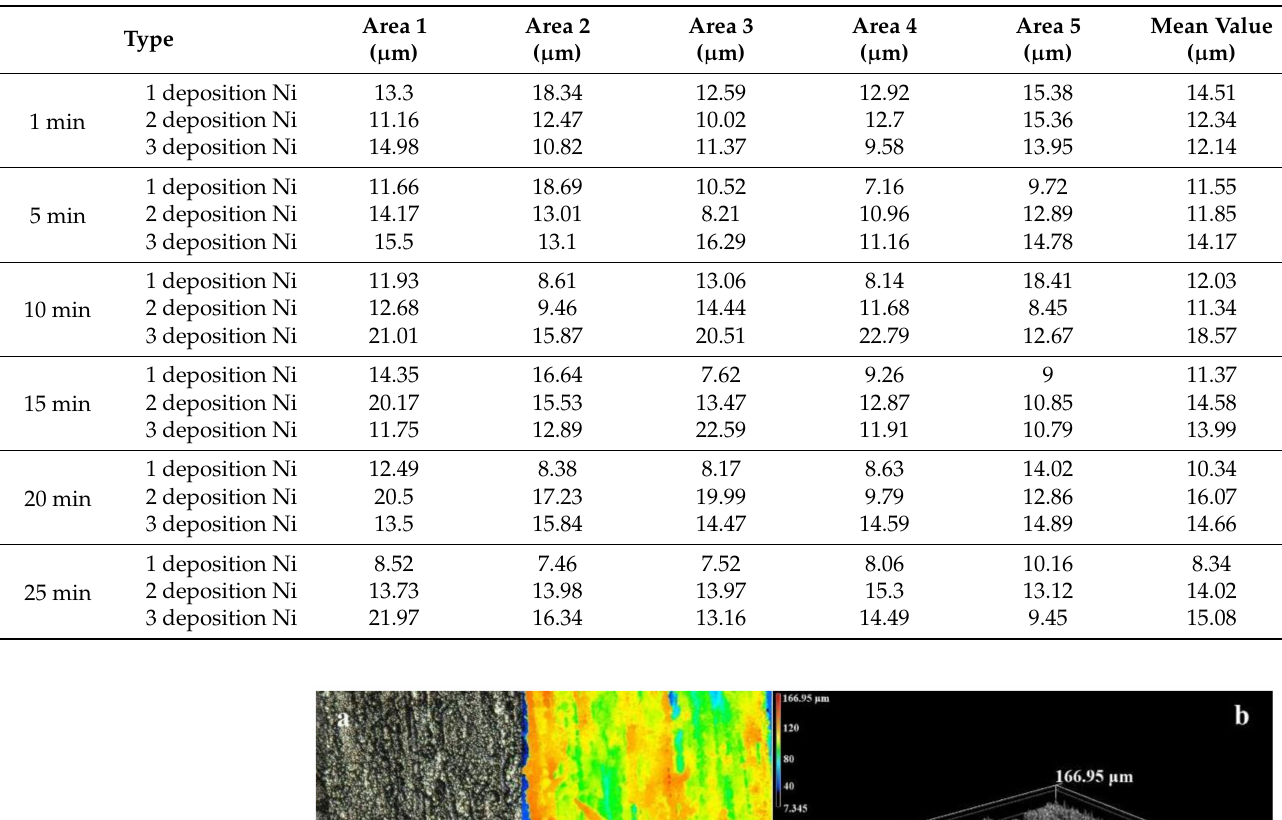
Table 3. Roughness of electroless Ni coating on wood surface via deposition Ni.